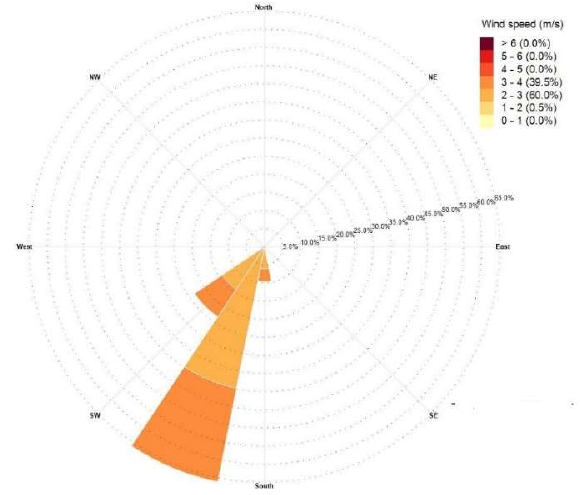
Figure 3: Wind rose